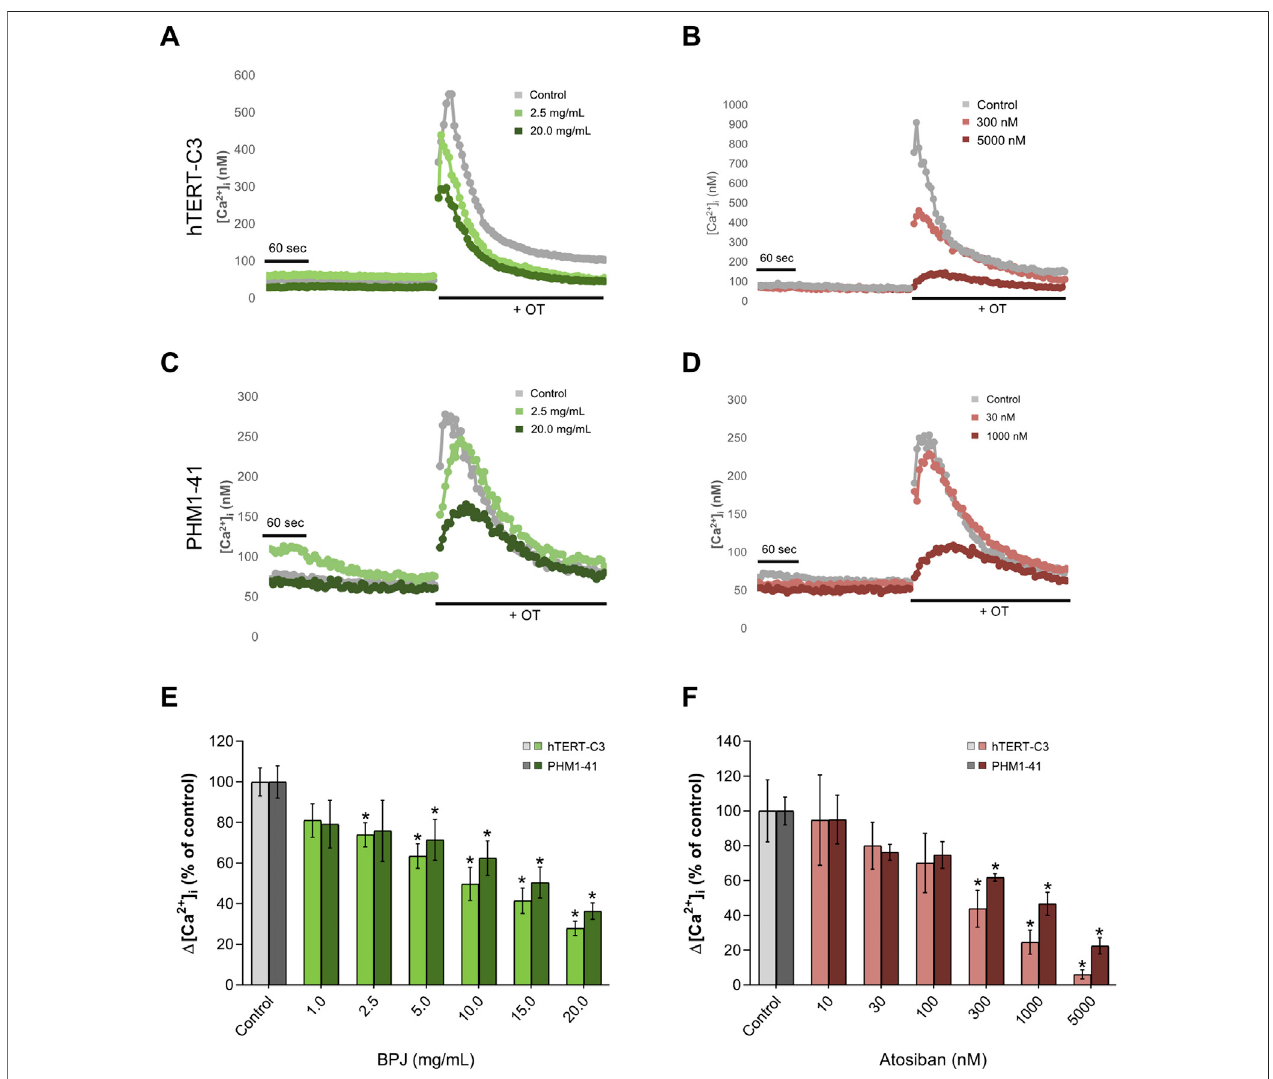
FIGURE3| ComparisonbetweentheeffectsofBPJandatosibanonOT-inducedriseof[Ca 2+ ] i inmyometrialcelllines.Time-courseofOT-induced[Ca 2+ ] i response in hTERT-C3 (A, B) and PHM1-41 (C, D) cells when pre-incubated in the absence (a-d, grey lines) or in the presence of BPJ (A, C) or atosiban (B, D) [Ca 2+ ] i was measured for 4 min before stimulation with 100 nM OT. Data shown are from one representative experiment. Concentration-dependent effect of BPJ (E) or atosiban (F) on the oxytocin-induced [Ca 2+ ] i increase in hTERT-C3 (lighter color) and PHM1-41 (darker color) cells. Values represent themean ± SEM of 4 (PHM1-41) or 6 (hTERT-C3) independent experiments performed in quadruplicate and are expressed as percentage of control; * p < 0.05.